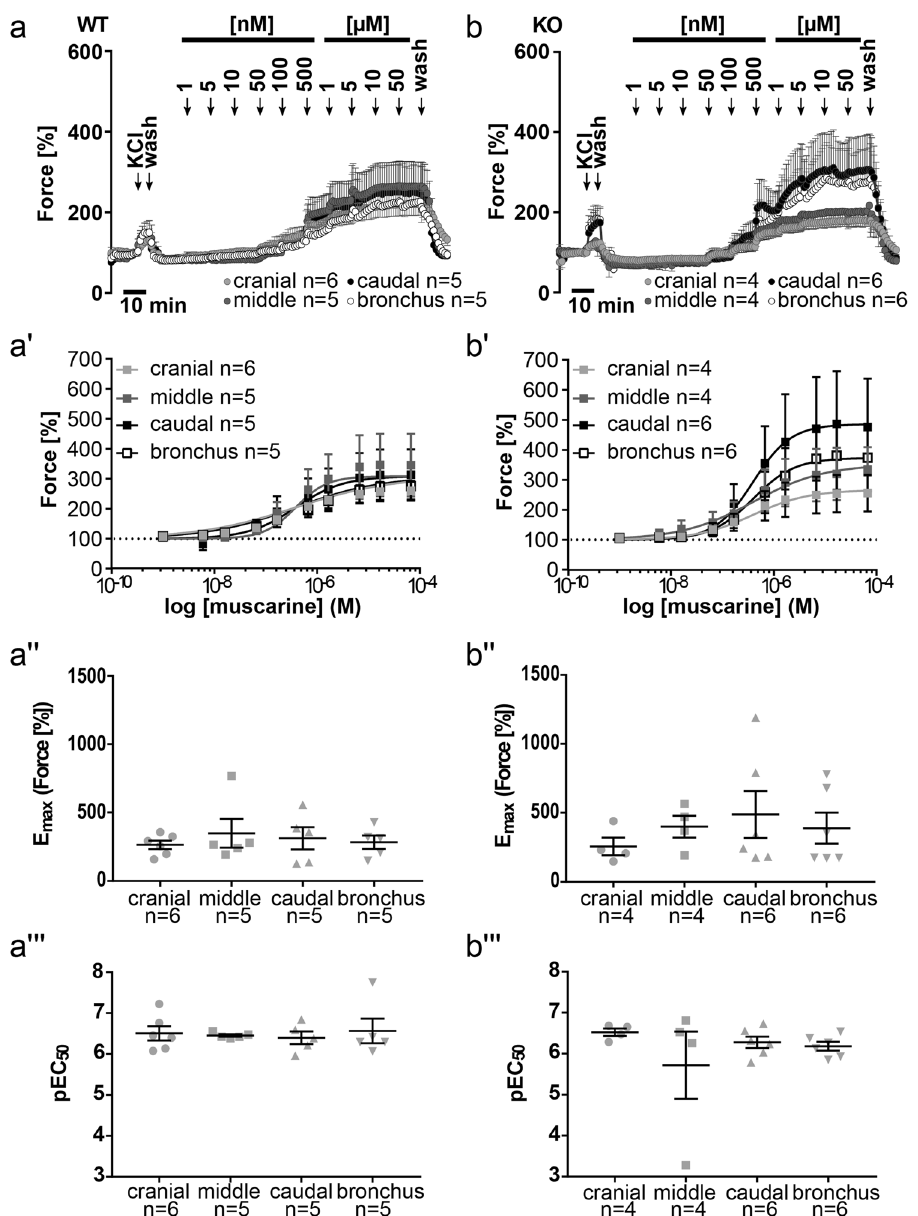
Figure 4. Changes in constrictor force and reactivity in response to muscarine in various airway segments from cav-3 + / + (WT) and cav-3 − / − (KO) mice. Tension changes were measured in force [grams]. After equilibration, baseline tension was always accustomed to 0.5 g. Baseline was set as 100% and the maximum response at each concentration was evaluated. Each point represents the mean number of animals (n) ± SEM. ( a , b ) Concentration- dependent contraction of ASM was induced by muscarine in cav-3 + / + ( a ) and cav-3 − / − ( b ) mouse strains. All sigmoidal concentration-response curves shown here were plotted according to the Hill equation. (a’-b’) Depicted is the constrictor force of different tracheal parts and extrapulmonary bronchi in cav-3 + / + (a’) and cav-3 − / − (b’) mice. No difference in maximal responses (E max , a” and b”) and pEC 50 (a”’ and b”’) values was observed in cav3 + / + and cav3 − / − mice between tracheal parts or bronchi when data were analyzed by One-Way ANOVA and subjected to Dunnett’s multiple comparisons test